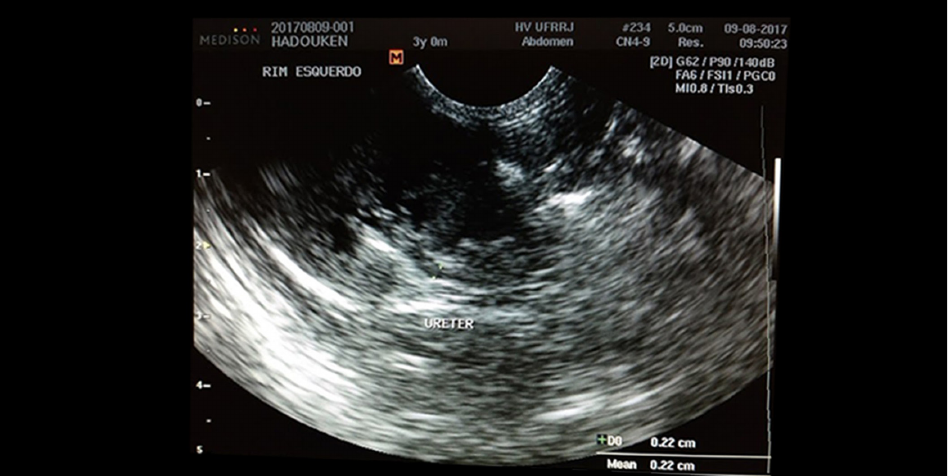
Figura 1. Imagem ultrassonografica antes do tratamento revelendo dilatação do ureter esquerdo medindo 0,22 cm.